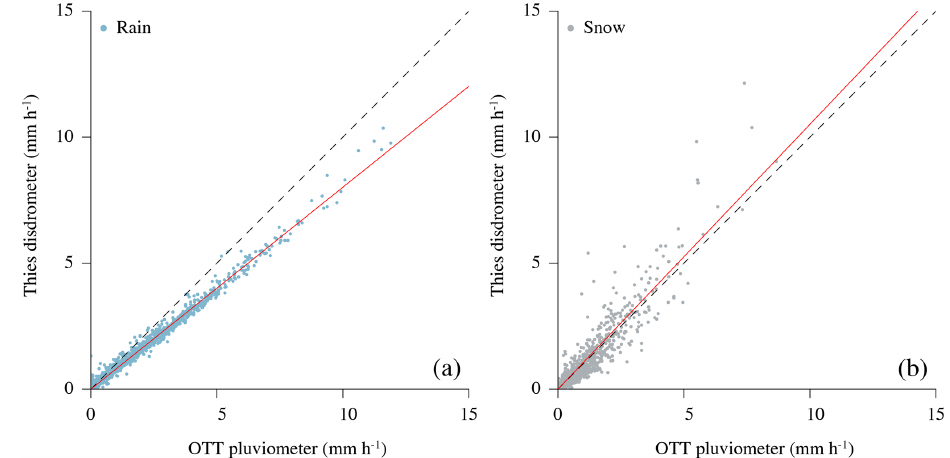
Figure 7. Precipitation intensities during periods of 30min as recorded by the Thies disdrometer and the OTT pluviometer during the whole time series (2 years). Precipitation is separated into rain (a) and snow (b) based on the recorded dominant precipitation type by the Thies disdrometer (1min). To highlight systematic errors, a linear regression is shown in both panels (red line), which is forced through the origin and has a slope of 0.80 for rainfall intensities and of 1.05 for snowfall intensities.